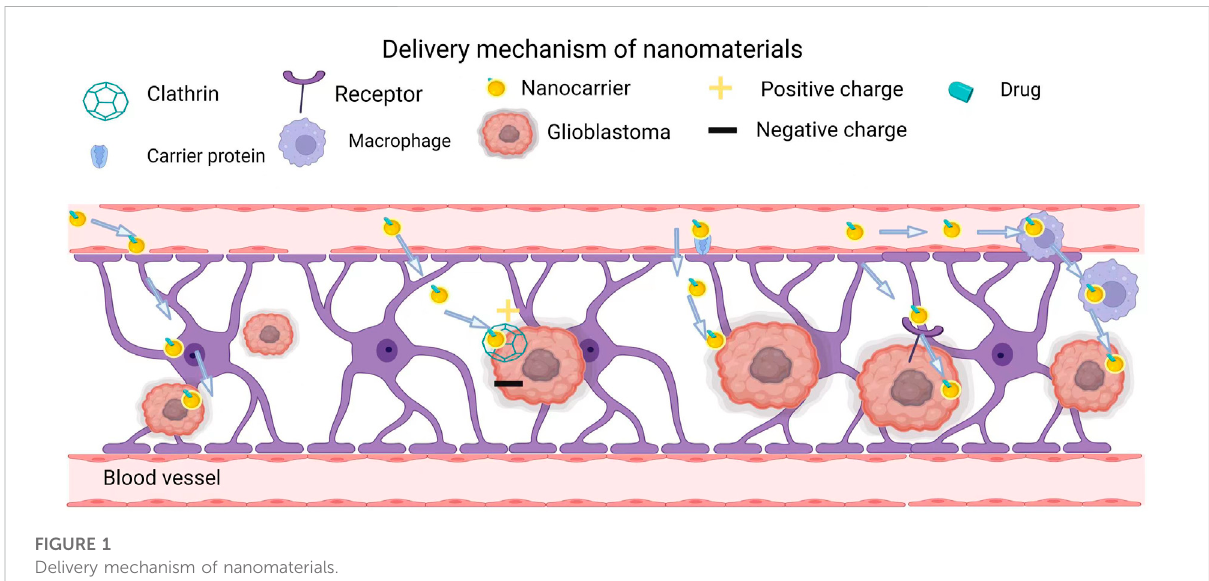
FIGURE 1 Delivery mechanism of